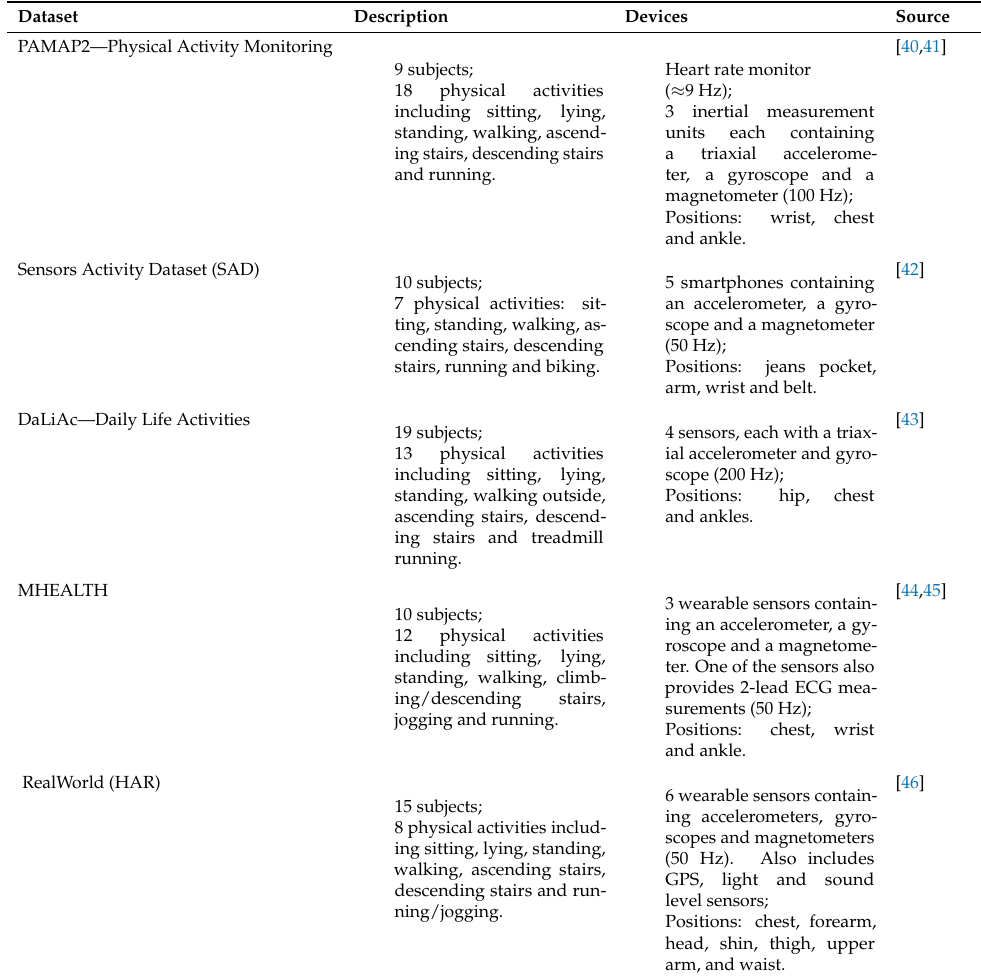
Table 1. Description of the datasets, including activities, positions, devices, and number of